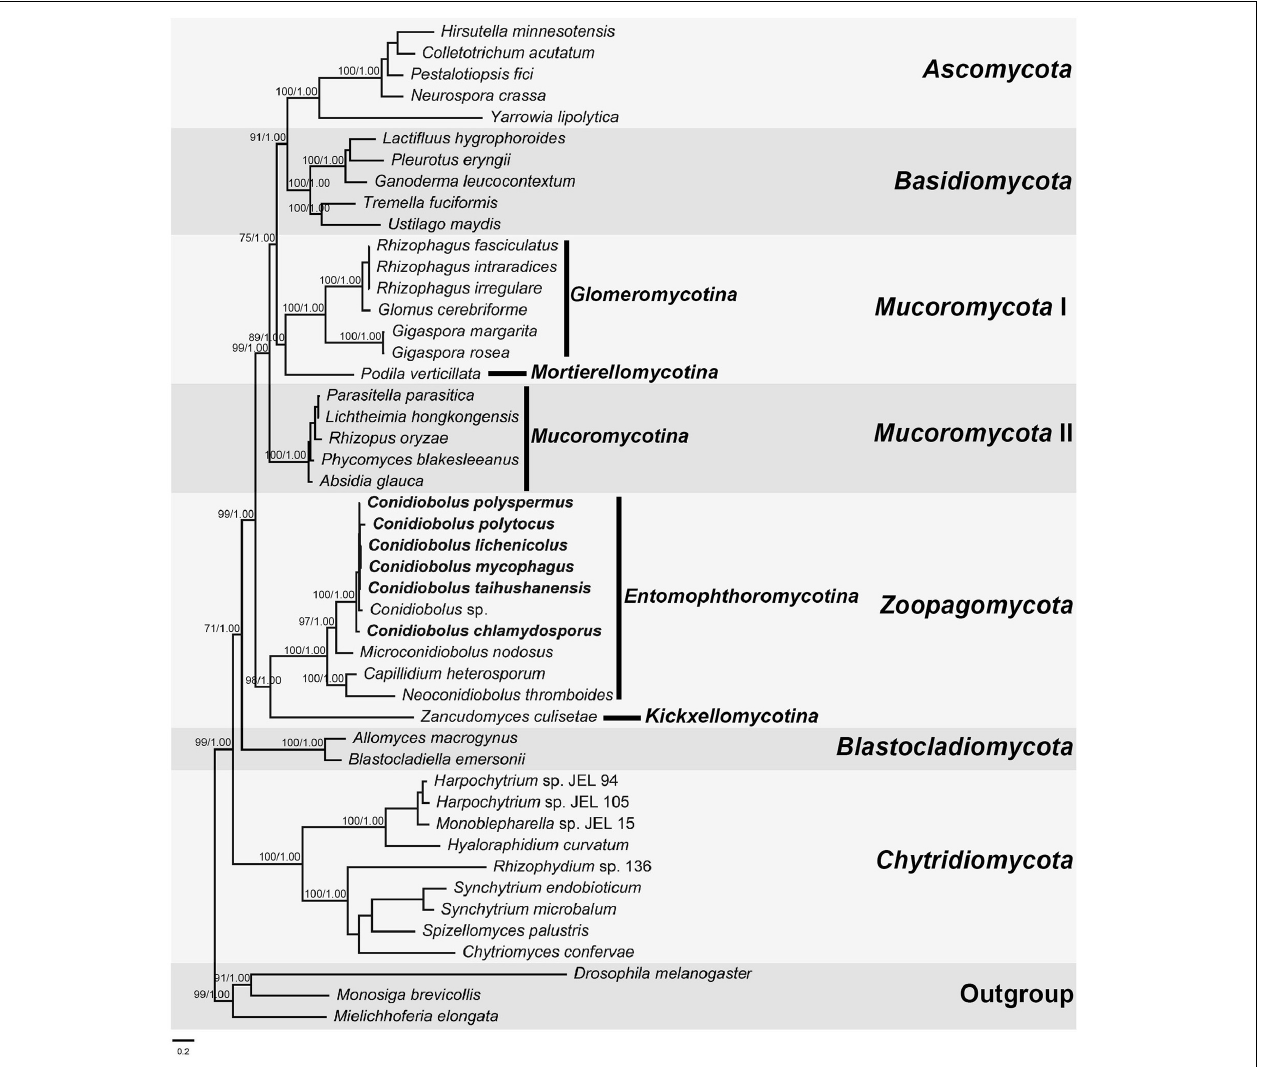
FIGURE 6 | The Maximum Likelihood (ML) phylogenomic tree of fungi based on 14 protein-coding genes (PCGs): cob , cox1 , cox2 , cox3 , nad1 , nad2 , nad3 , nad4 , nad4L , nad5 , nad6 , atp6 , atp8 , and atp9 . Support values for ML and Bayesian analysis (BI) greater than 70% and 0.95, respectively, are given on relative clade. Drosophila melanogaster , Mielichhoferia elongata , and Monosiga brevicollis serve as outgroups. The lower left bar represents 0.2 substitutes per